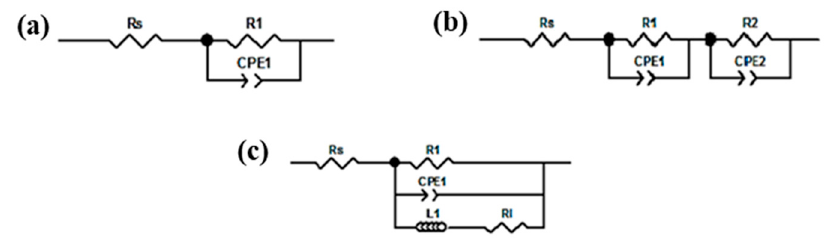
Figure 11. Equivalent circuits of ( a ) Colmonoy, ( b ) Inconel, and ( c ) Al coatings at 40 °C.